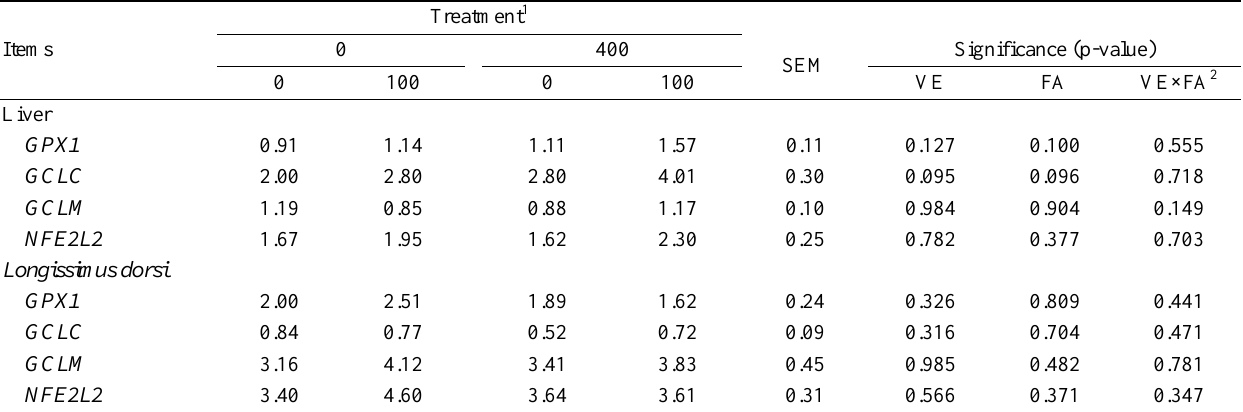
Table 5. Effect of dietary supplementation with vitamin E (VE) and ferulic acid (FA) on the mRNA expressions of NFE2L2-ARE related genes in liver and longissimus dorsi muscle of finishing pigs (n = 6)